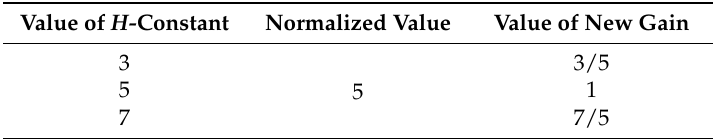
Table 2. Normalizing system of H